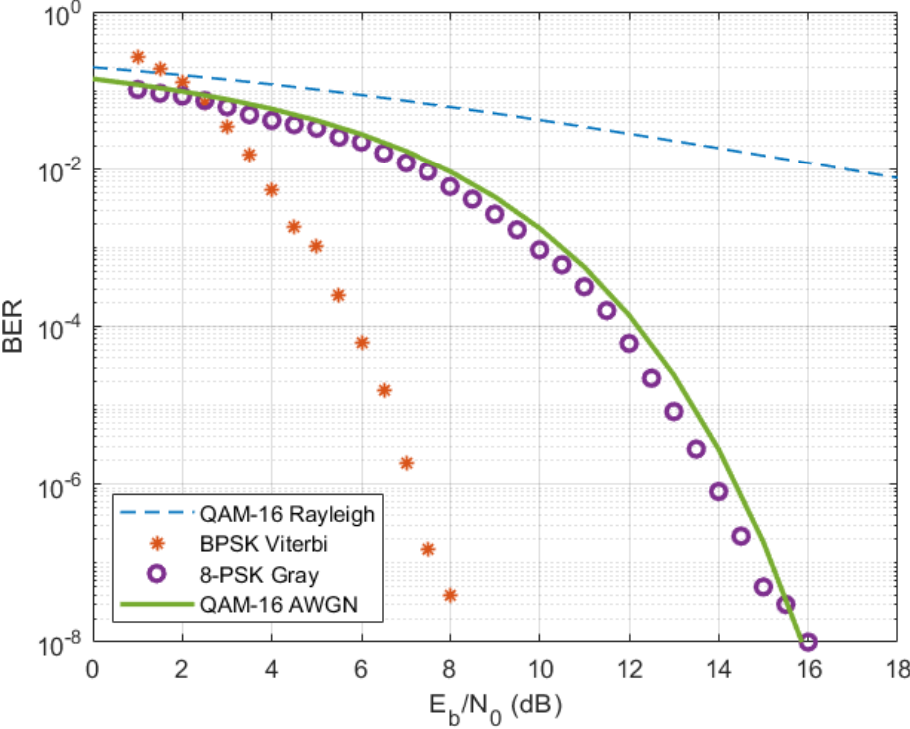
Figure 6. BER vs Eb/No simulation results for different modulation schemes and channel condition assumptions.